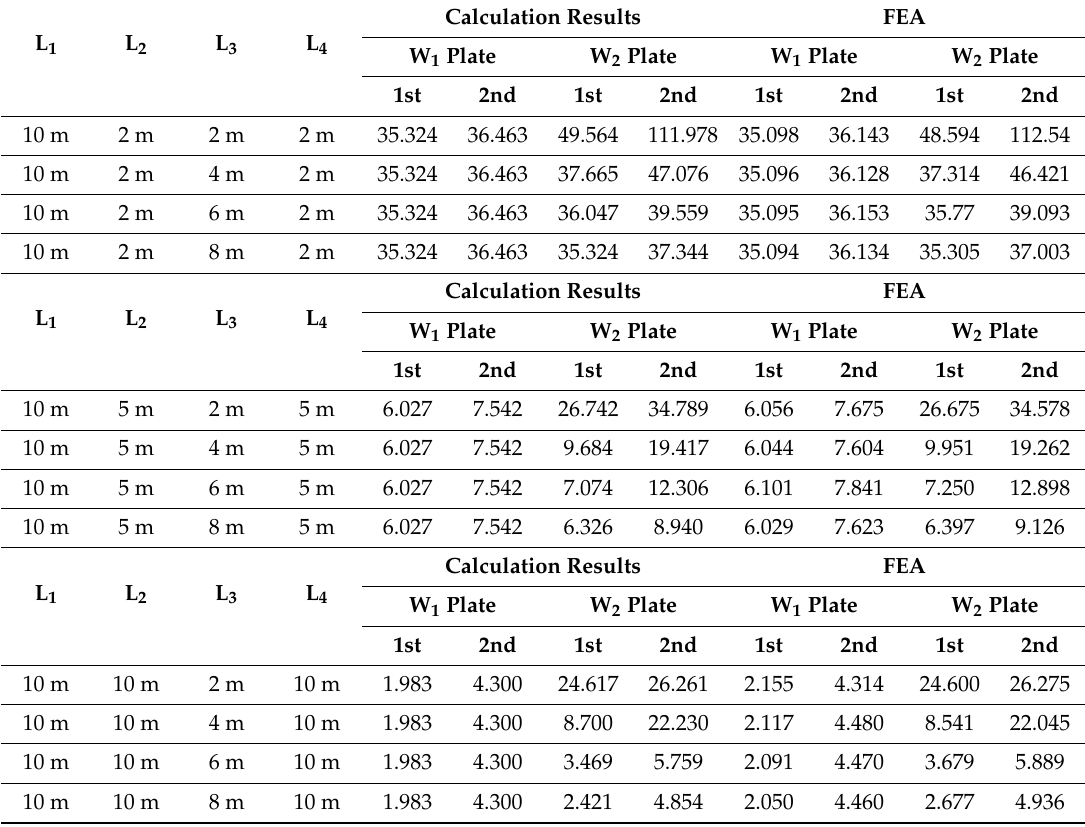
Table 7. The comparison of results (unit: Hz).